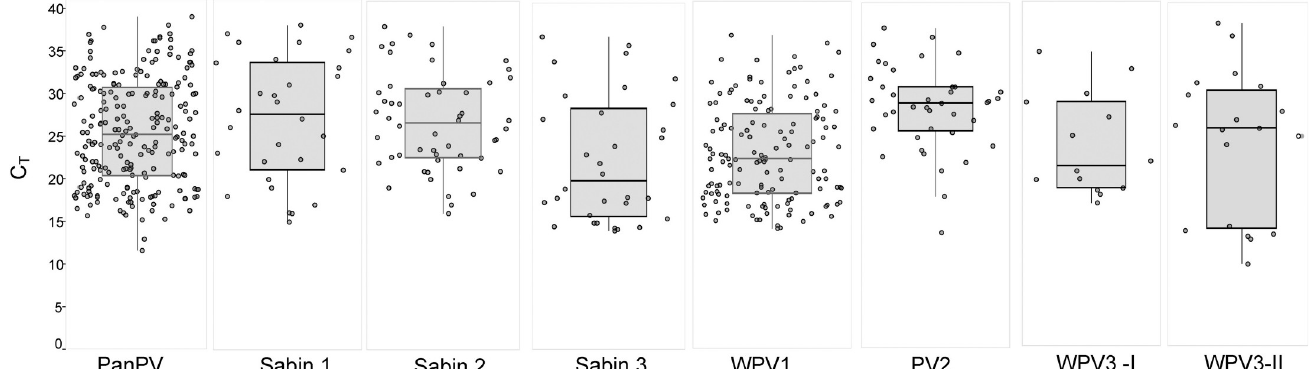
Fig 2. Parallel testing assay-by-assay results for PV-positive stools. Poliovirus RNA was extracted after PVR-His enrichment and screened in ITD real-time RT-PCR for all samples. C T values are shown by ITD assay and when positive in PVR-His enrichment/RNA extraction but negative in virus isolation.